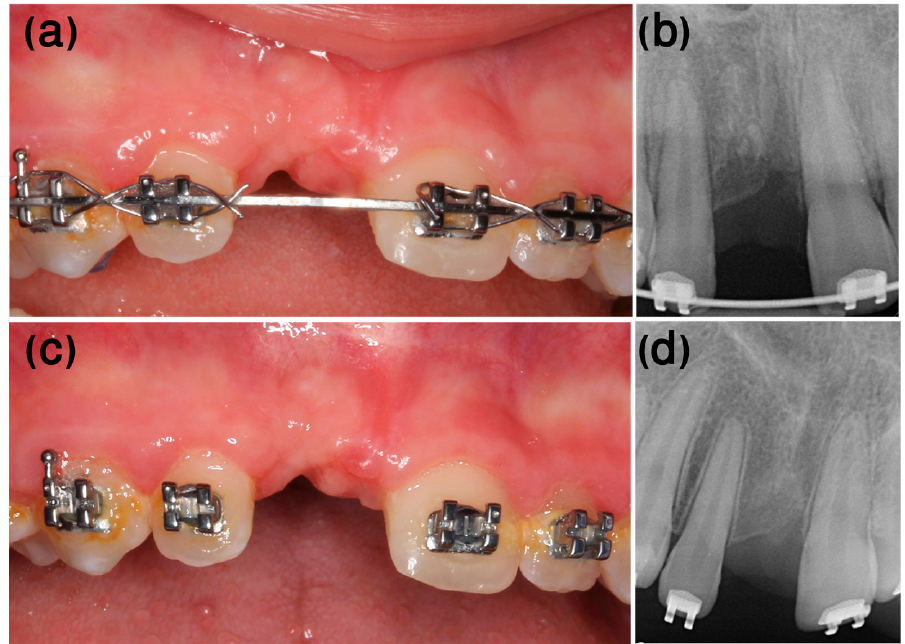
Figure 14. Case 2, post-surgery follow-ups. ( a , b ) Six-month follow-up. ( c , d ) One-year follow-up.